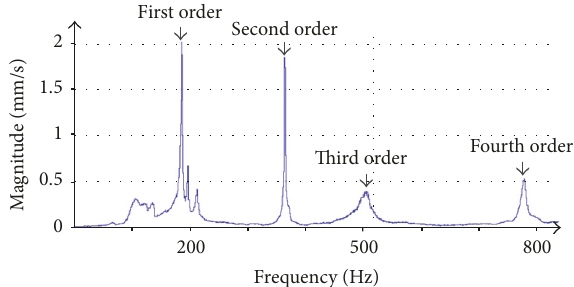
Figure 6: Experimental natural frequency of first four orders of thin-walled plates under a 50 N preload. Table 2: Average error of the natural frequency values of the first four orders from simulation and experiment. Natural frequency